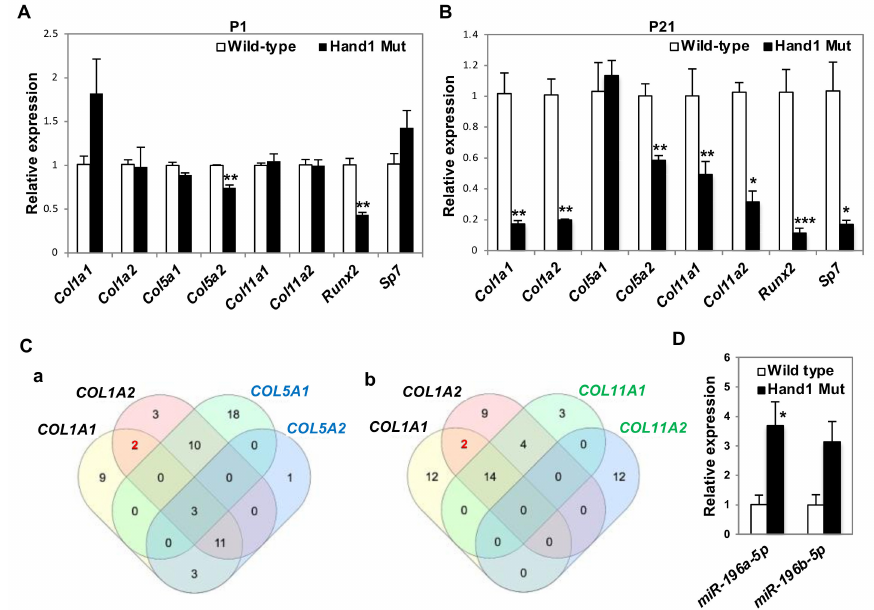
Figure 3. Expression of bone-related collagen genes are significantly decreased in the cortical bones of Hand1 -overexpressing mice. ( A , B ) Real-time quantitative PCR analysis of bone-related collagen genes and their direct regulators in wild-type and Hand1 -overexpressing mice ( n = 3 per genotype) at postnatal (P) day 1 ( A ) and P21 ( B ). Expression of bone-related collagens, Col1a1, Col1a2, Col5a2, Col11a1 , and Col11a2, and their regulators, Sp7 / Osterix and Runx2, were significantly decreased in Hand1 -overexpressing mice (Hand1 Mut) at P21. Data are represented as the mean ± standard error of mean (S.E.M). * p < 0.05; ** p < 0.01; *** p < 0.001 (compared to the wild-type). ( C ) ( a ) The number of putative miRNAs targeting collagen alpha chains ( COL1A1, COL1A2 , COL5A1, and COL5A2 ) are depicted in the Venn diagram using multiple list corporator (http: // molbiotools.com). Two miRNAs (shown in red) commonly and specifically target COL1A1 and COL1A2. ( b ) The number of putative miRNAs targeting collagen alpha chains ( COL1A1, COL1A2 , COL11A1, and COL11A2 ) are depicted in the Venn diagram. Two miRNAs (shown in red) commonly and specifically target COL1A1 and COL1A2. Putative miRNAs that target collagen alpha chains are shown in Table S4. ( D ) Real-time quantitative PCR analysis of miR-196a and miR-196b in wild-type and Hand1 -overexpressing mice ( n = 3 per genotype) at P21. miR-196a was significantly upregulated in Hand1 -overexpressing mice (Hand1 Mut). * p < 0.05 (compared to the